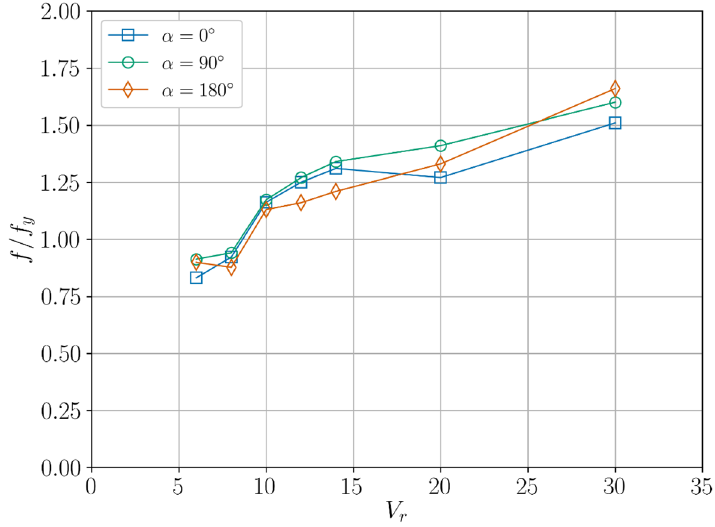
Figure 13. Transverse response frequency ratio of FOWT platform under different current incidence conditions.